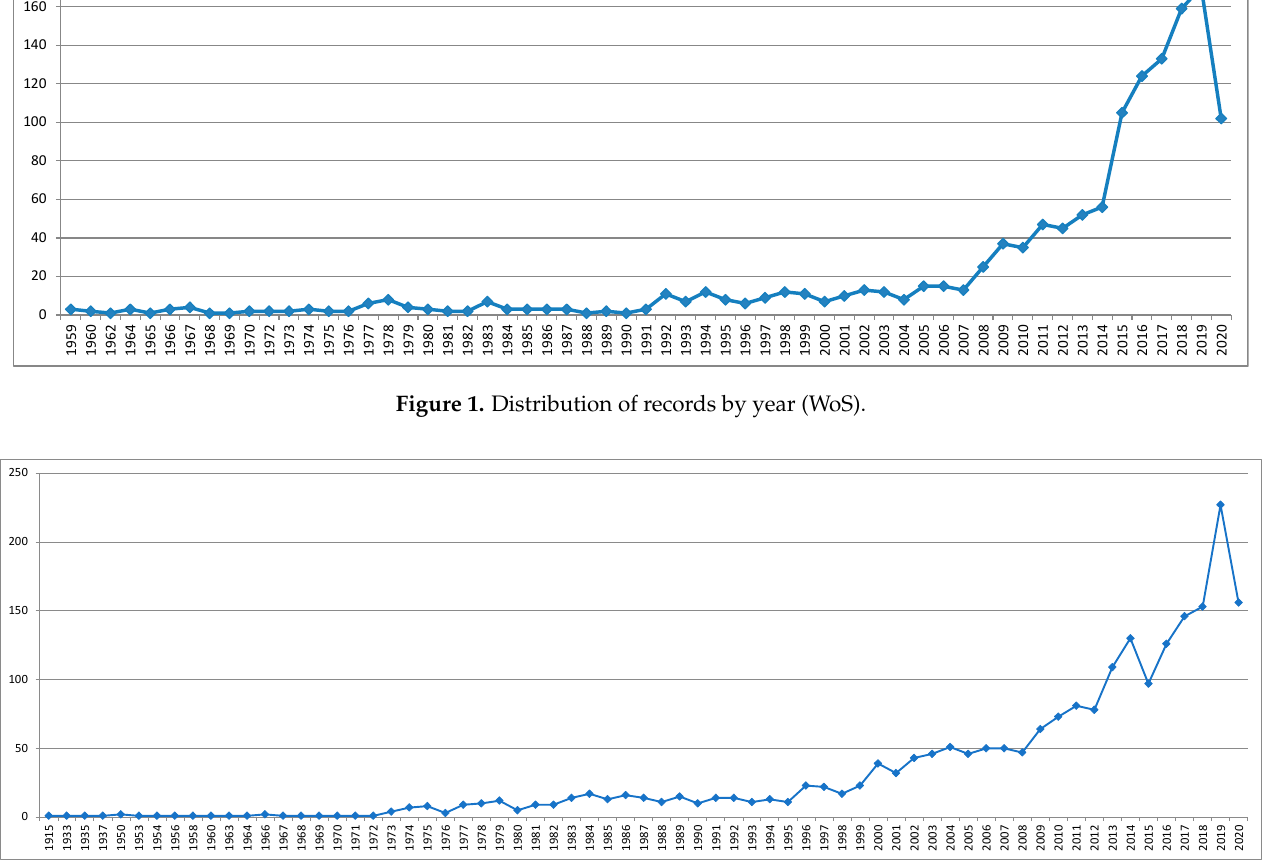
Figure 2. Distribution of records by year (Scopus).